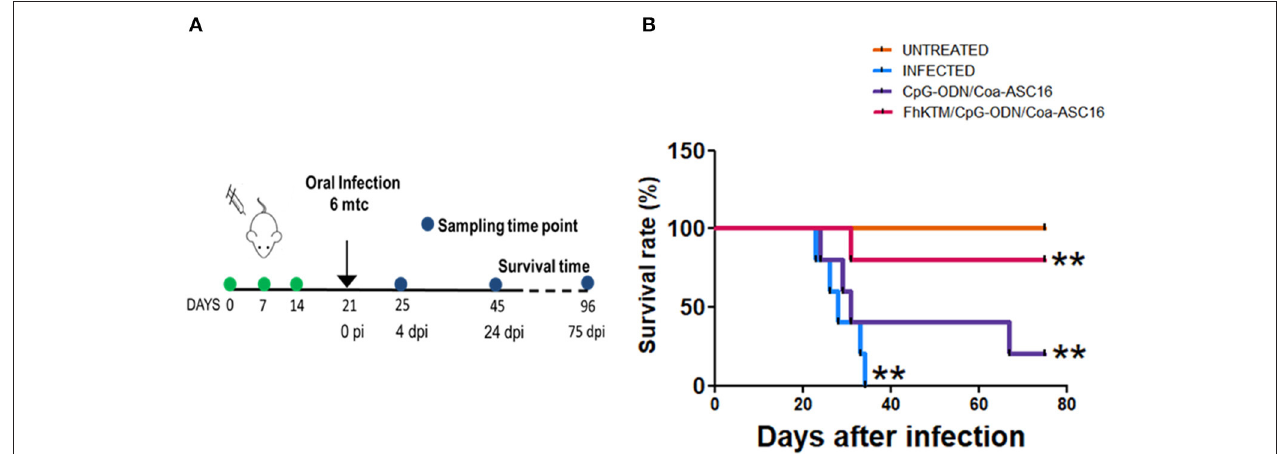
FIGURE 1 | Vaccination with FhKTM/CpG-ODN/Coa-ASC16 increases the survival rate in F. hepatica infected mice. (A) Scheme of the vaccination and challenge experiments. BALB/c mice were injected s.c. in the upper and dorsal region on days 0, 7, and 14 with FhKTM/CpG-ODN/Coa-ASC16, CpG-ODN/Coa-ASC16, or PBS (infected). One week later, the mice were oral-challenged with 6 metacercariae of F. hepatica . Non-vaccinated non-infected (untreated) mice were used as a negative control group. The samples were obtained at 4 and 24 dpi. (B) Survival was monitored for > 75 days. Each group comprised of five mice. Survival was significantly higher in the FhKTM/CpG-ODN/Coa-ASC16-immunized mice than in the control groups. Kaplan–Meier curves were generated and survival was compared across groups using the log-rank test ** p < 0.05. This figure is representative of two experiments with similar